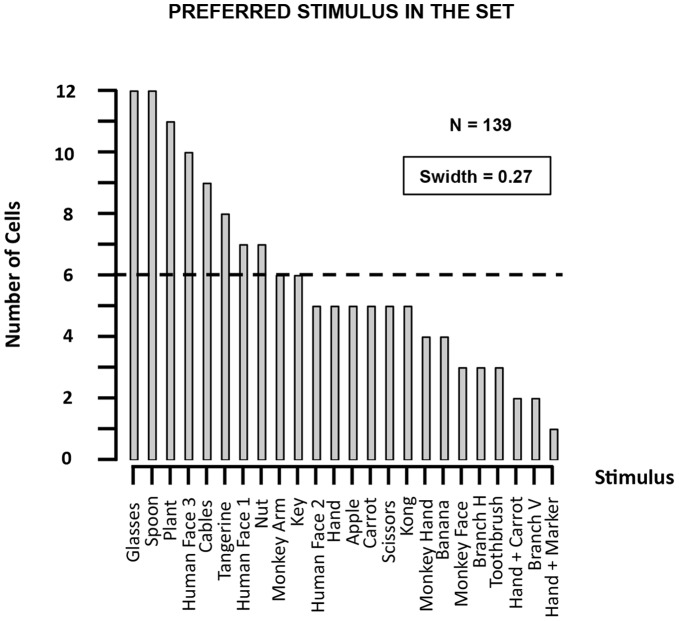
Search Test.For each stimulus in the Search Test, we plotted the number of neurons that gave the maximal response to that image. The images are ranked from the highest (left) to the lowest number of neurons preferring each particular image.